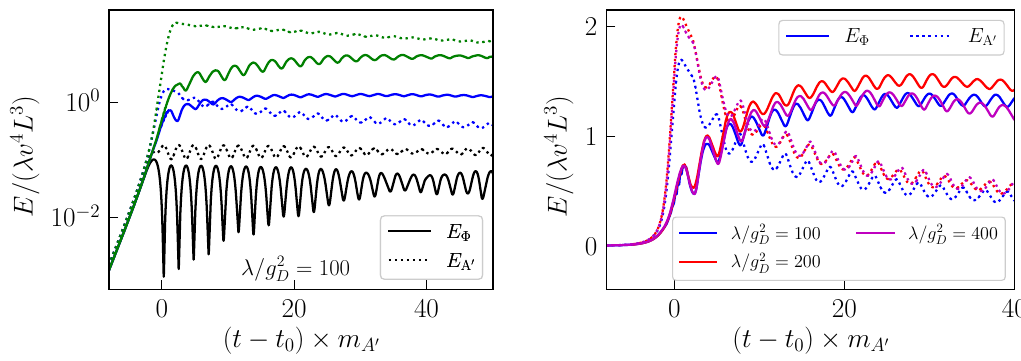
Figure 7 . Energy in the scalar field (including interaction energy with the vector; solid lines) and energy in the vector field (not including interaction energy; dashed lines) as a function of time. Left Panel: we show three different cases with λ/g 2 = 100 where the time t 0 when the axion instability D is shut off increases by increments of ≈ 1 . 2 /m A 0 going from black, to blue, to green. In the case when the axion instability is shut off the earliest (black lines), no vortices form, while in the other two cases, they do. For the x-axis, time is scaled to the value of t 0 for the intermediate case (blue curves). Right Panel: we compare three different cases with λ/g D = 100 , 200, and 400, and with t 0 chosen to give approximately the same value of E Φ /λ at the time when the instability is shut off. The blue curves ( λ/g 2 = 100 ) are the same case as in the intermediate case in the left panel. D